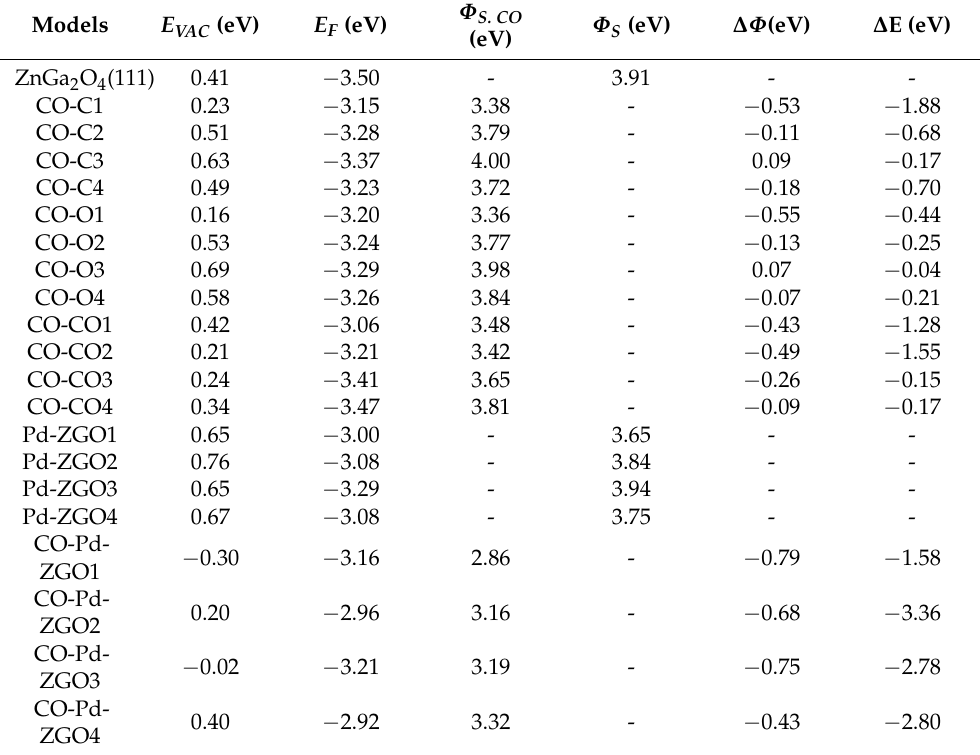
Table 1. Calculated vacuum energy E VAC , Fermi energy E F , work function with CO molecules Φ S. CO , and without CO molecules Φ S , work function changes ∆ Φ , and adsorption energy ∆ E